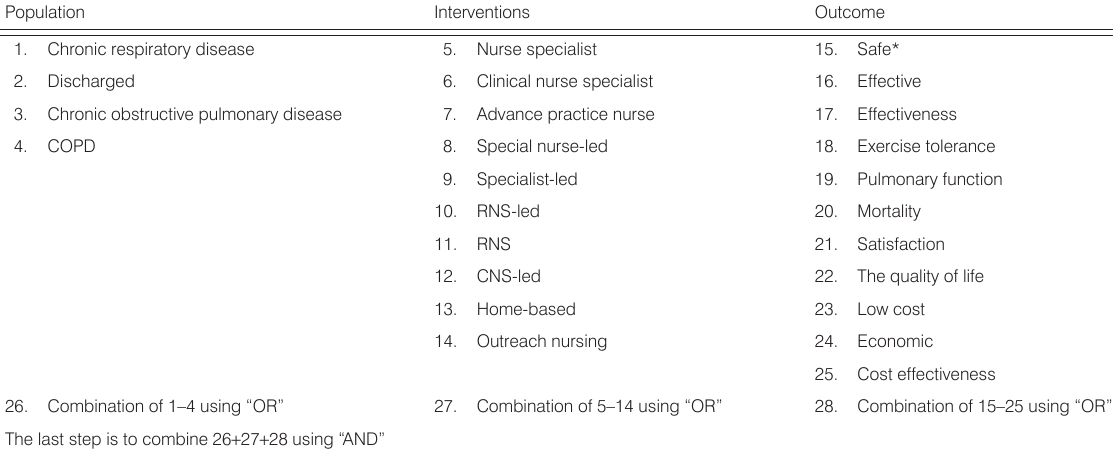
Table 1. Alternative keywords and search